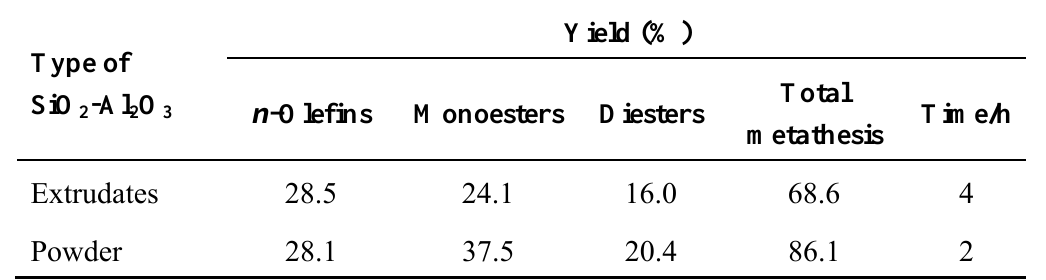
Table 1. Yield (in mol%) of products resulting from self-metathesis of methyl linoleate with a 3% Re temp (20 °C)].